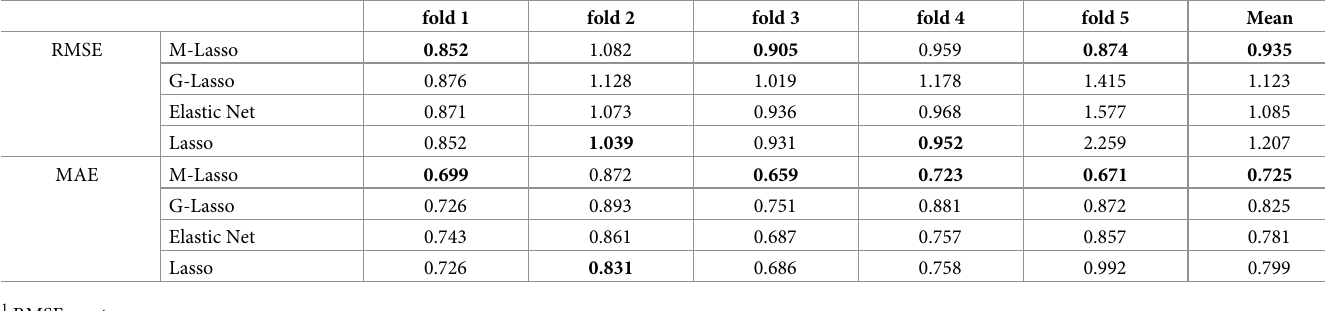
Table 2. Performance comparison on test set between M-Lasso and other